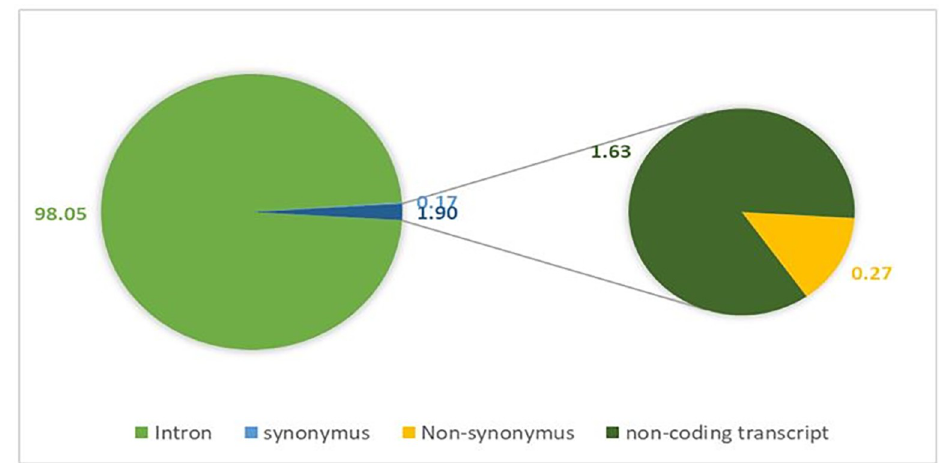
Fig 1. Percentages of various kinds of SNPs in human FOXP2 protein. Intronic SNPs: 98.05%; nsSNPs: 0.28%; synonymous SNPs: 0.17%; non-coding transcript: 1.63%.